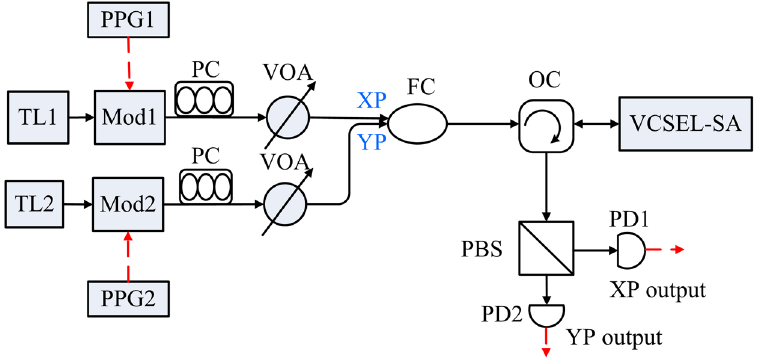
Figure 1. The schematic illustration of dual-channel spike encoding based on VCSEL-SA. TL1 and TL2: tunable laser; Mod1 and Mod2: modulator; PPG1 and PPG2: pulse signal generator; PC: polarization controller; VOA: variable optical attenuator; FC: fiber couple; OC: optical circulator; VCSEL-SA: vertical-cavity surface-emitting laser with an embedded saturable absorber; PBS: polarization beam splitter; PD1 and PD2: photodetector. The solid (dashed) lines correspond to optical (electrical)